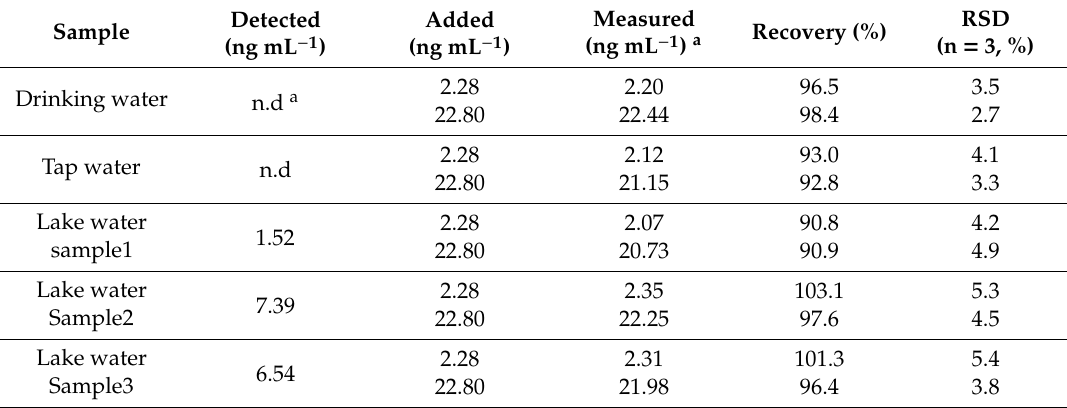
Table 2. Detection of BPA in real water samples using FeO x / ZnS@MIPs sensor. Sample